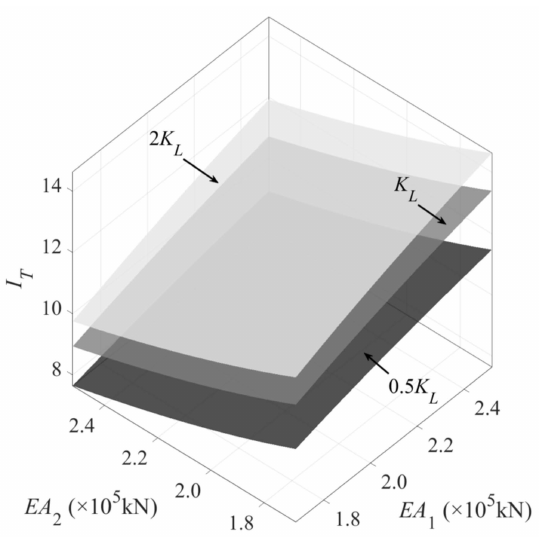
Figure 2. The relationship between damage diagnosis indicators and structural